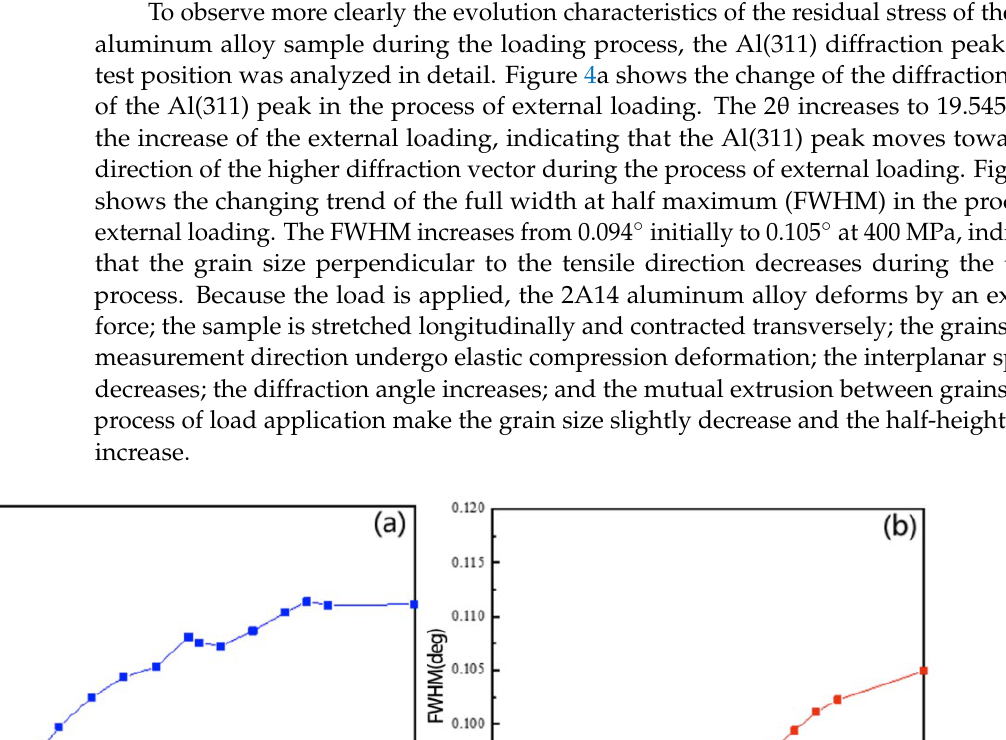
Figure 5. Variation of in situ loading process. ( a ) Crystal plane spacing; ( b ) residual stress. 3.2. Diffraction Information of 2A14 Aluminum Alloy under Temperature Field As the 2A14 aluminum alloy samples underwent heating–holding–cooling, the tem- perature was set at 200 °C for 30 min, and the heating rate was 13–15 °C/min. When the temperature reached 200 °C, it was held for 10 min, 20 min and 30 min, respectively, and then we collected the diffraction information. During the heating and cooling process, the diffraction information was collected every 5 min. The diffraction information with dif- ferent temperatures is shown in Figure 6.